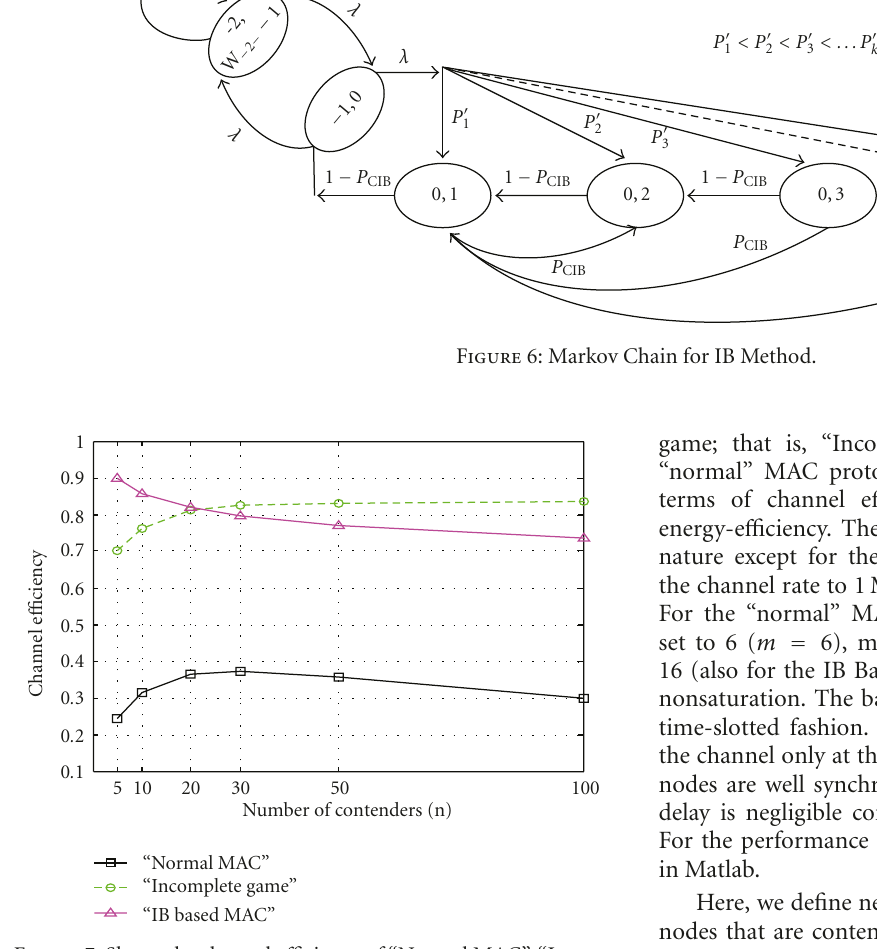
Figure 7: Shows the channel e ffi ciency of “Normal MAC”, “Incom- plete Game” and “IB Based